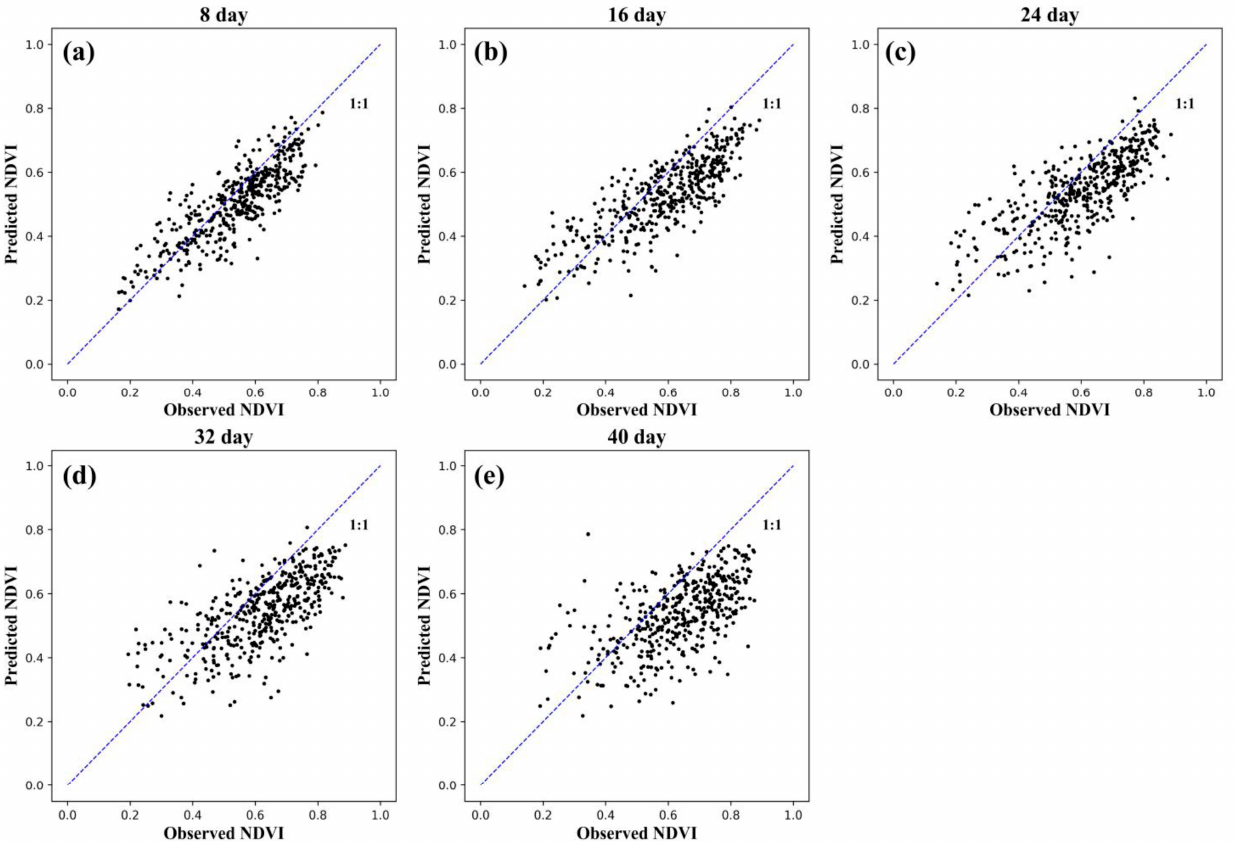
Figure 7. Scatter plot of predicted and observed NDVI values using the DTW–LSTM method for different prediction horizons. ( a ) 8 days, ( b ) 16 days, ( c ) 24 days, ( d ) 32 days, ( e ) 40 days. Table 2. r, MAE, MAPE and RMSE of predictions using the DTW–LSTM method for different pre- diction horizons.